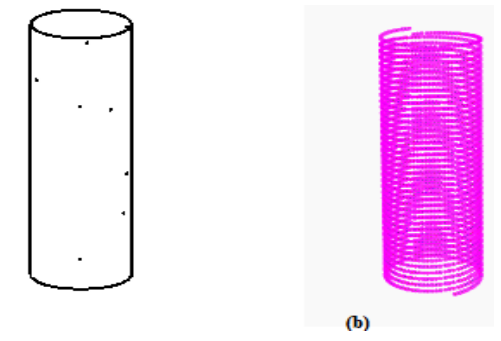
Figure 7. ( a ) Element created in Revit TM ; ( b ) element printing trajectory.